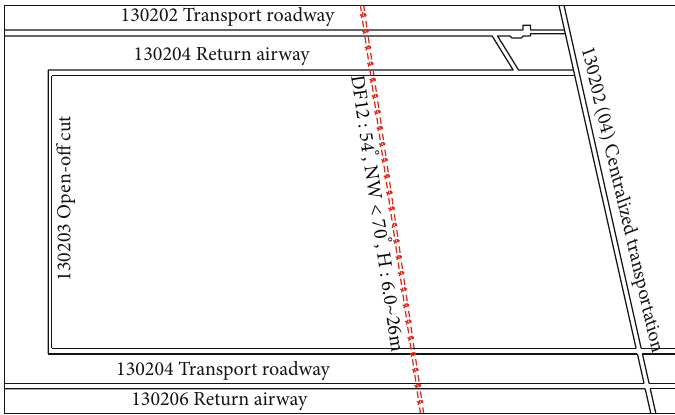
Figure 2: 130204 fully mechanized mining face layout.